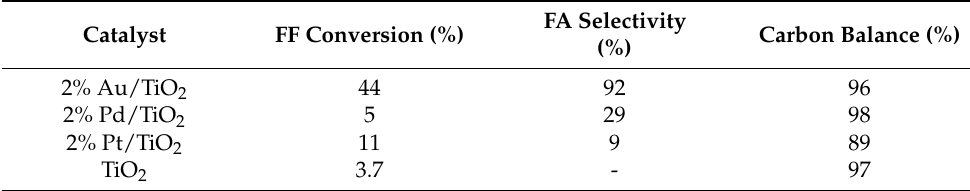
Table 2. Catalytic results obtained for monometallic catalysts (T = 110 ◦ C, P(O 2 ) = 15 bar, t = 2 h, 600 rpm, FF/Au =